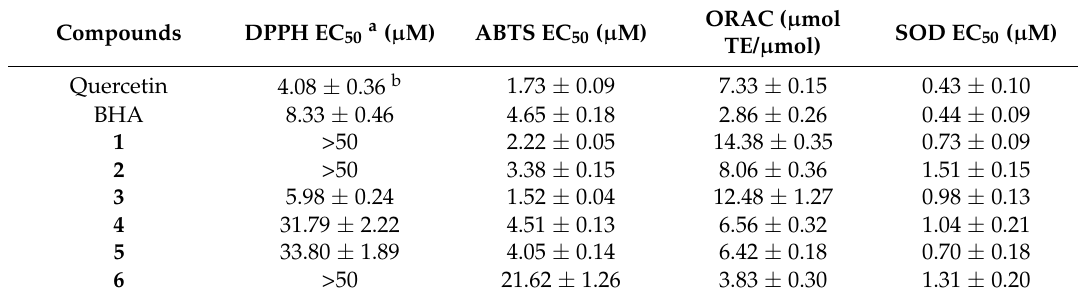
Table 1. Antioxidant activities of flavonoids 1 – 6 on DPPH, ABTS, ORAC, and SOD assays. Compounds DPPH EC 50 a ( µ M) ABTS EC 50 ( µ M)